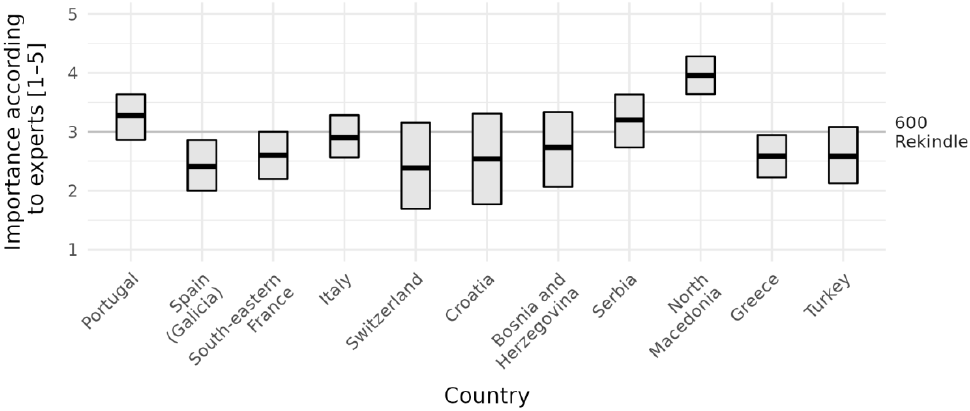
10 Figure 10. Crossbar plot of the importance of ignitions due to Rekindle , according to the smean.cl.boot function from the Hmisc R-package, grouped by